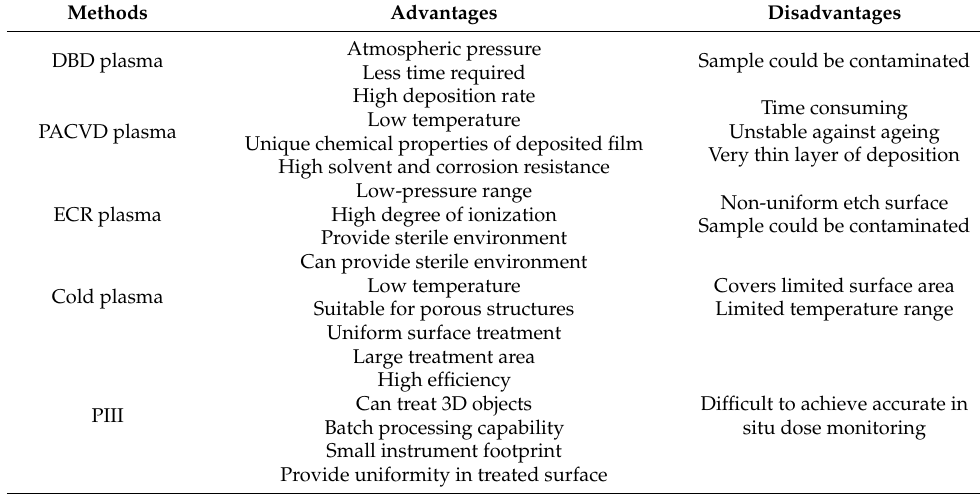
Table 9. Advantages and disadvantages of different plasma methods